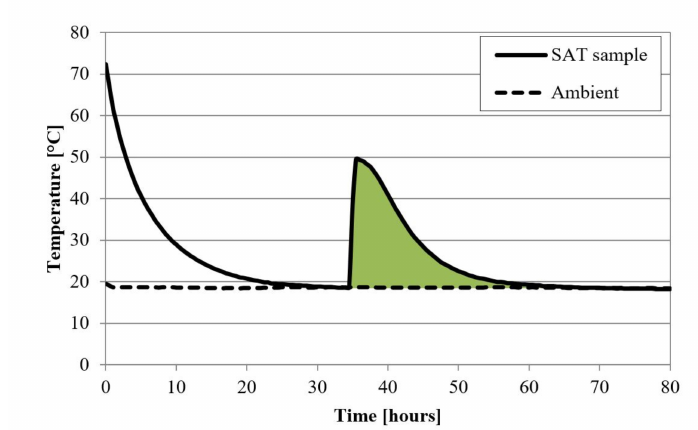
Figure 25. Exemplary cooling process of PCM samples in the device “DTU heat loss method”. DTU Multiple Storage